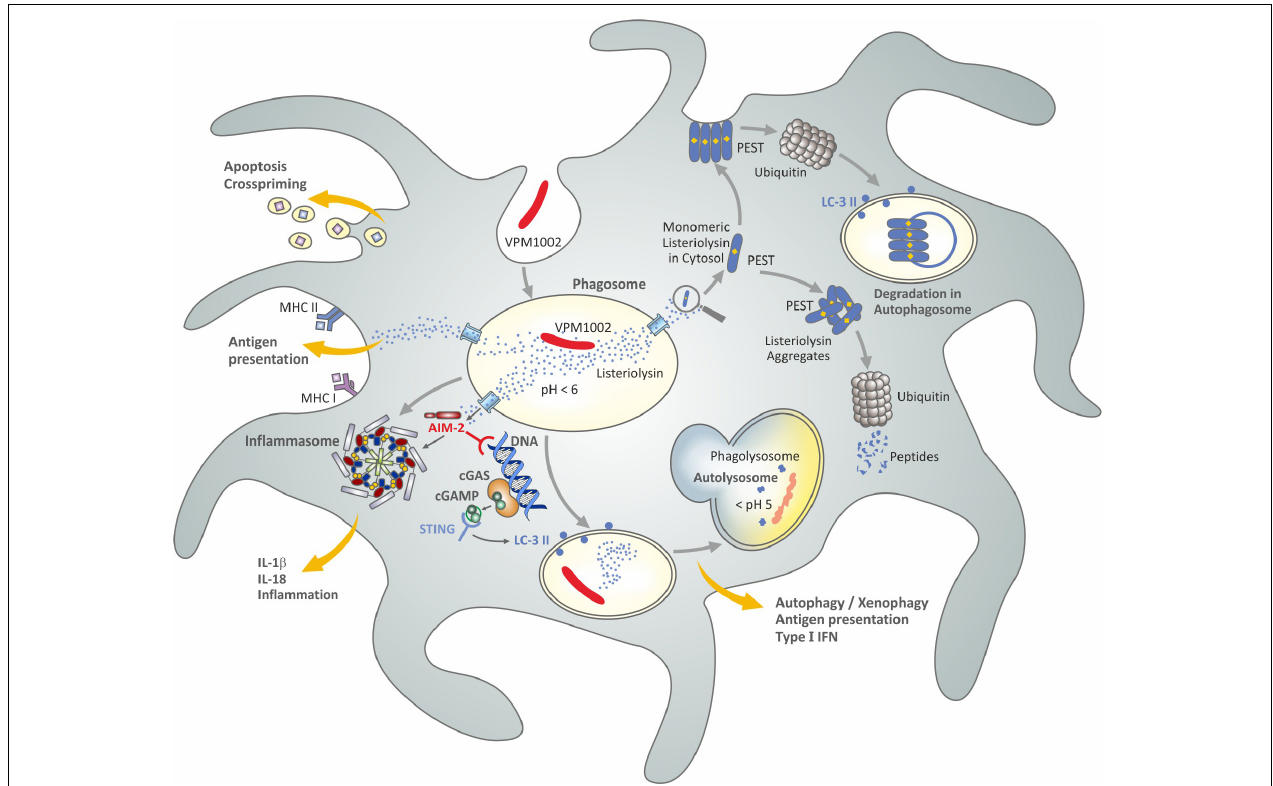
FIGURE 6 | Simplified scheme of potential mechanisms induced by VPM1002 underlying a better safety and efficacy profile over BCG. Figure modified from Kaufmann (2020) and based on published data (Hess et al., 1998; Conradt et al., 1999; Decatur and Portnoy, 2000; Grode et al., 2005; Winau et al., 2006; Farinacci et al., 2012; Saiga et al., 2015; Chen et al., 2018; Nguyen et al.,